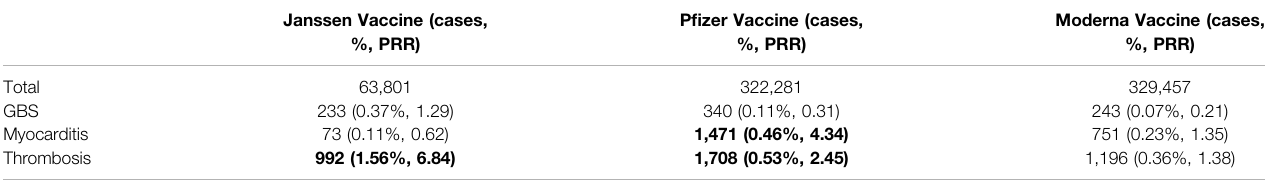
TABLE4| Casereportcounts,frequencies,andPRRsof3representativeAEsfortheJanssen,Moderna,andP fi zervaccines.Boldedvaluesrepresentstatisticallysigni fi cant AEs for the corresponding vaccine.